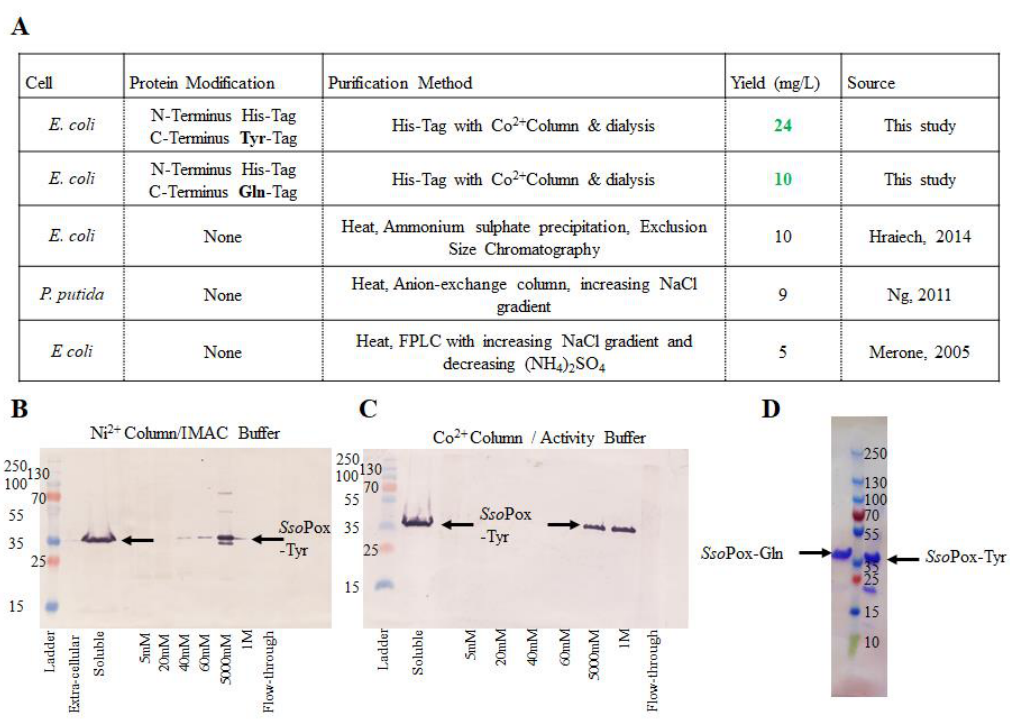
Table 1. Purified Sso Pox-Tyr/Gln. A summary of the construction, purification and yield of the enzymes developed in this work are compared to previous work in ( A ). ( B ) and ( C ) depict